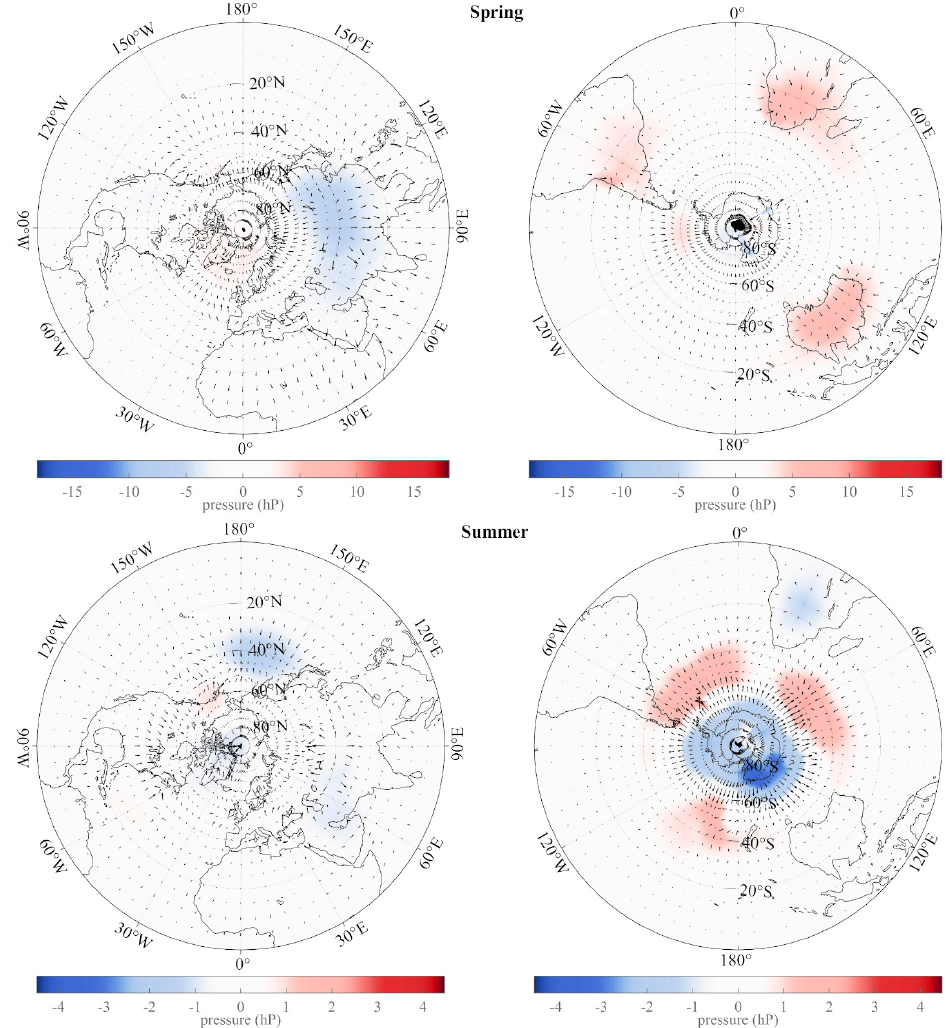
Figure 8. Polar views of northern hemisphere (left column) and southern hemisphere (right column) showing the trend (iSSA component 1 from Lopes et al. [1]), and maps of iSSA components 2 (annual) and 3 (semi-annual) for all springs since